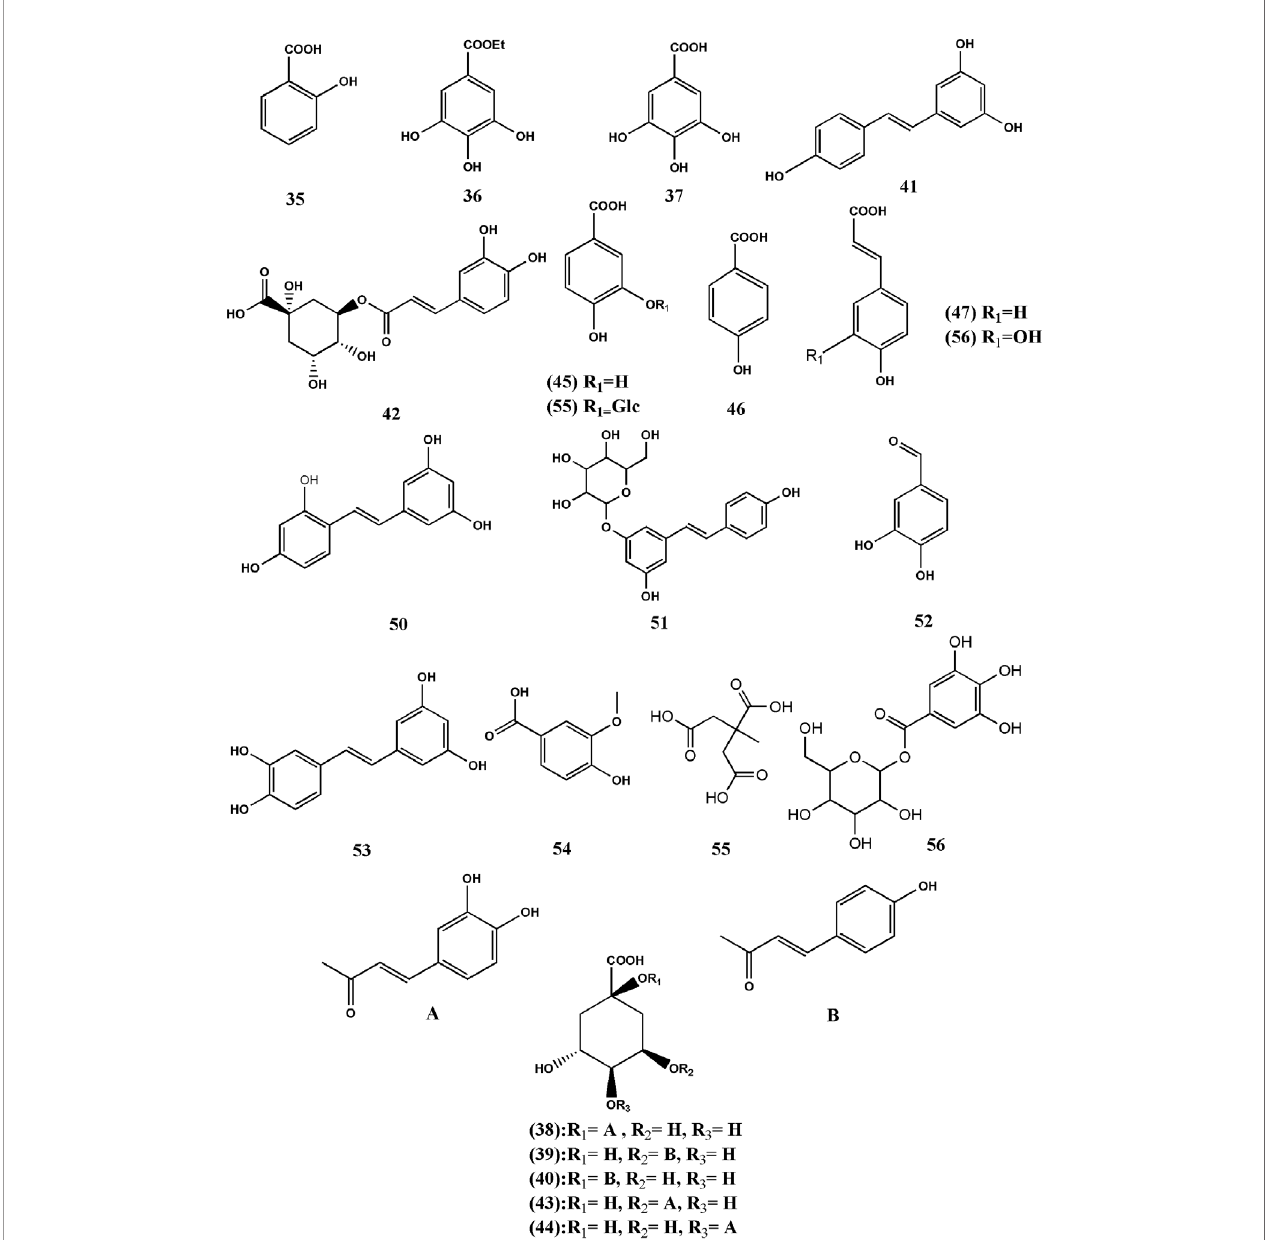
FIGURE 3 | Structures of phenolic acids from Tetrastigma hemsleyanum Diels &